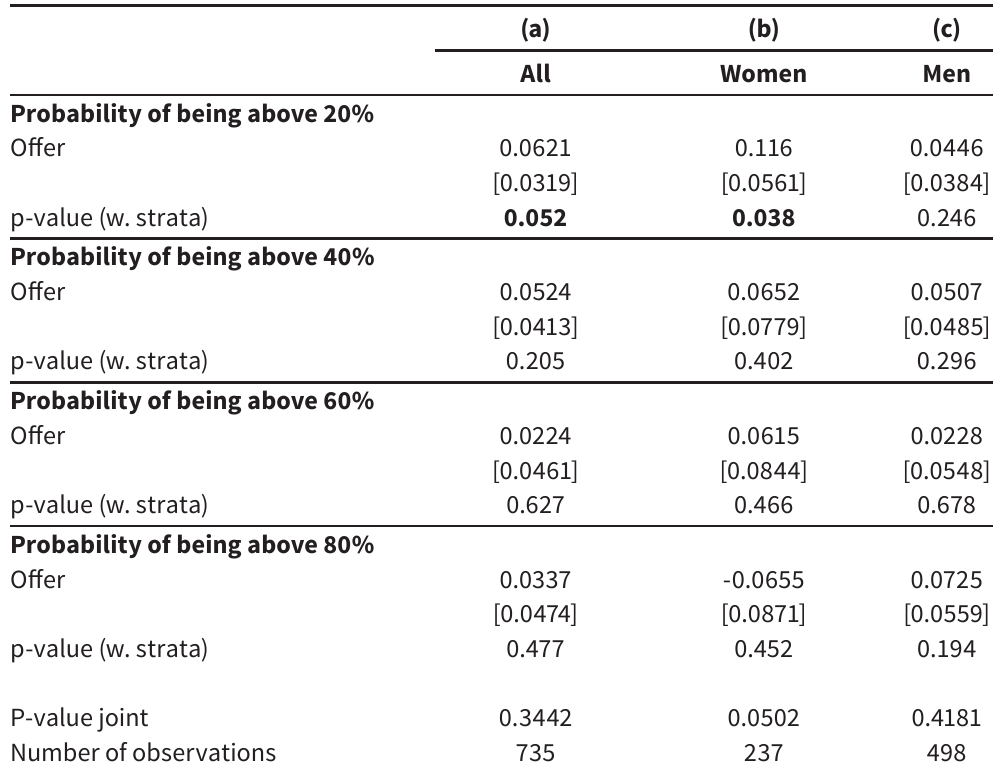
Table 8 Average Intent-to-treat Estimates on Probability of being above Quantiles of Stan- dardized Index of Non-cognitive Skills (a) (b) (c) All Women